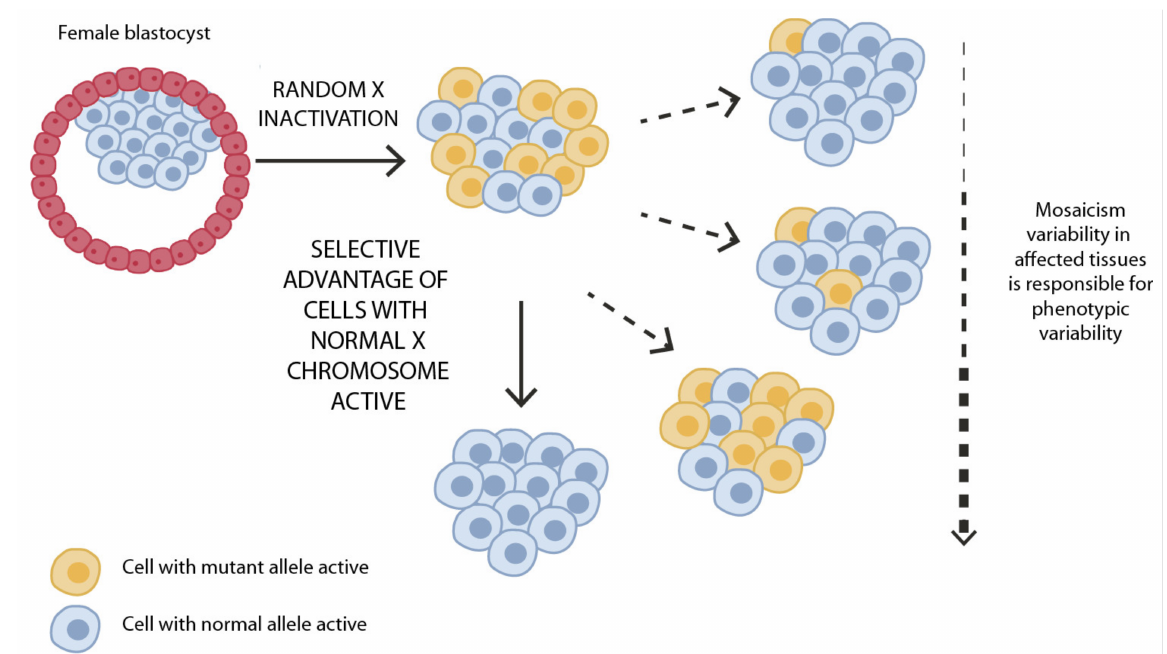
Figure 2. Schematic representation of XCI in female somatic cells. In normal conditions, the ratio of the two cell types (carrying the active and the inactive X chromosome) is approximately 50:50, but in females with X-linked dominant disorders, this ratio may be different, due to a potential disadvantage for cells expressing a mutant X-linked allele. Divergence from the 50:50 ratio, known as skewing of XCI, can be different in various tissues, in different developmental stages, and may vary among individuals, causing variability in the severity of the phenotype observed. For disorders such as LSDMCA, affected females usually have totally skewed patterns of XCI, in favor of an active wild-type X